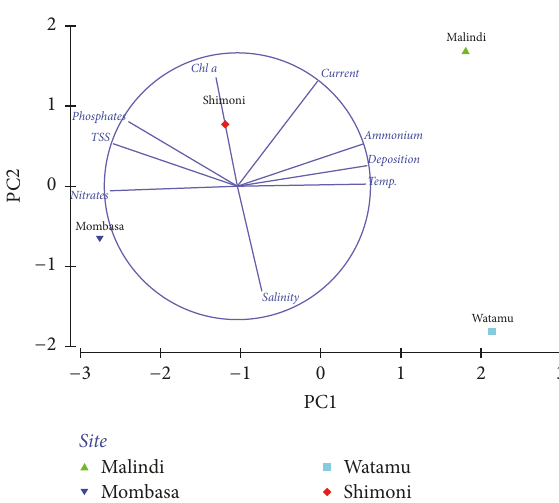
Figure 5: Principal component analysis plot of component 1 versus component 2. Temp.: temperature; TSS: total suspended sediments; Chl a : chlorophyll a